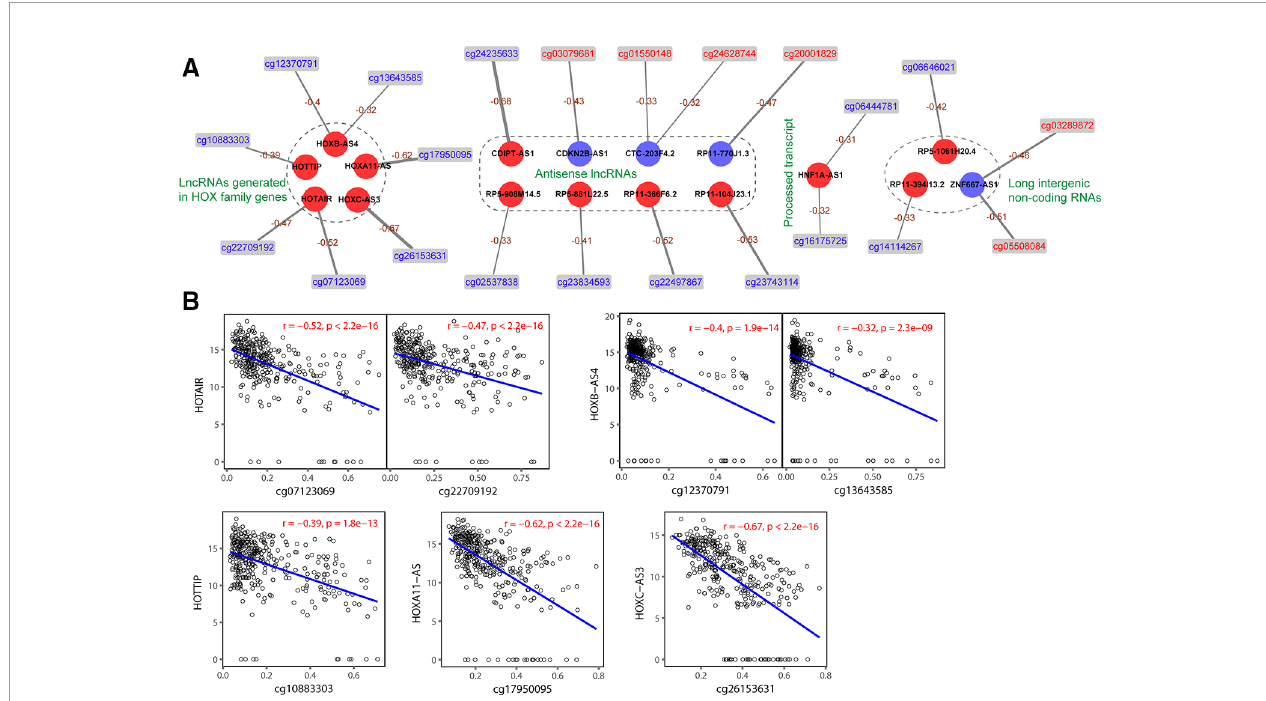
FIGURE 3 | Relation between DNA methylation and long noncoding RNA (lncRNA) expression. (A) Correlation between differentially methylated CpGs (DMCs) and lncRNAs. Circles and rectangles represent lncRNAs and DMCs, respectively. Red color indicates upregulated or hypermethylated, and blue indicates downregulated or hypomethylated. (B) Correlation (P values derive from Spearman's correlation) between DNA methylation and the expression of HOX family genes associated with fi ve lncRNAs in matched samples.